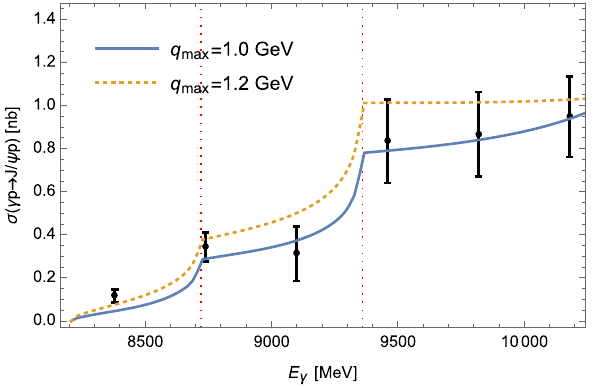
Fig. 4 Comparison of the J /ψ photoproduction through the open- charm loops as shown in Figs. 2 and 3 with the GlueX data [19]. E γ is the photon energy in the rest frame of the initial proton. Since we consider only the Λ c ¯ D ( ∗ ) channels, the comparison with the data is only shown up to E γ = 10 . 2 GeV though a qualitative agreement up to the highest GlueX data point 11.6 GeV is also achieved. The vertical dotted lines indicate the Λ c ¯ D ( ∗ ) thresholds